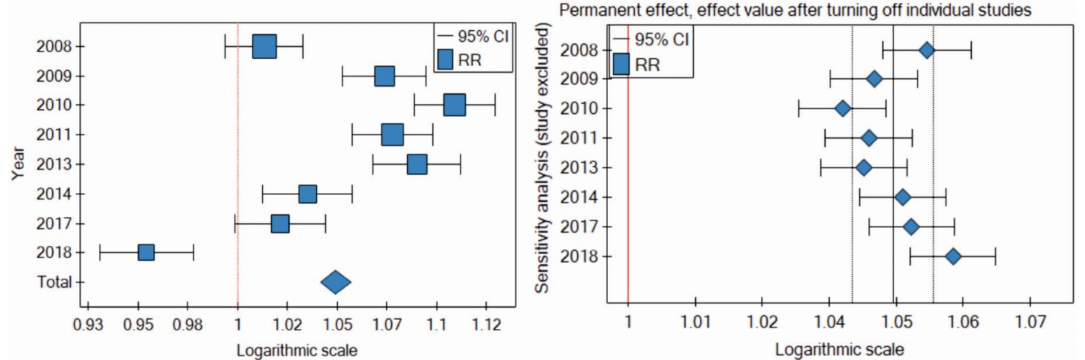
Figure 6. The relative risk of an accident at work among workers aged 50–54 years employed in Poland (own